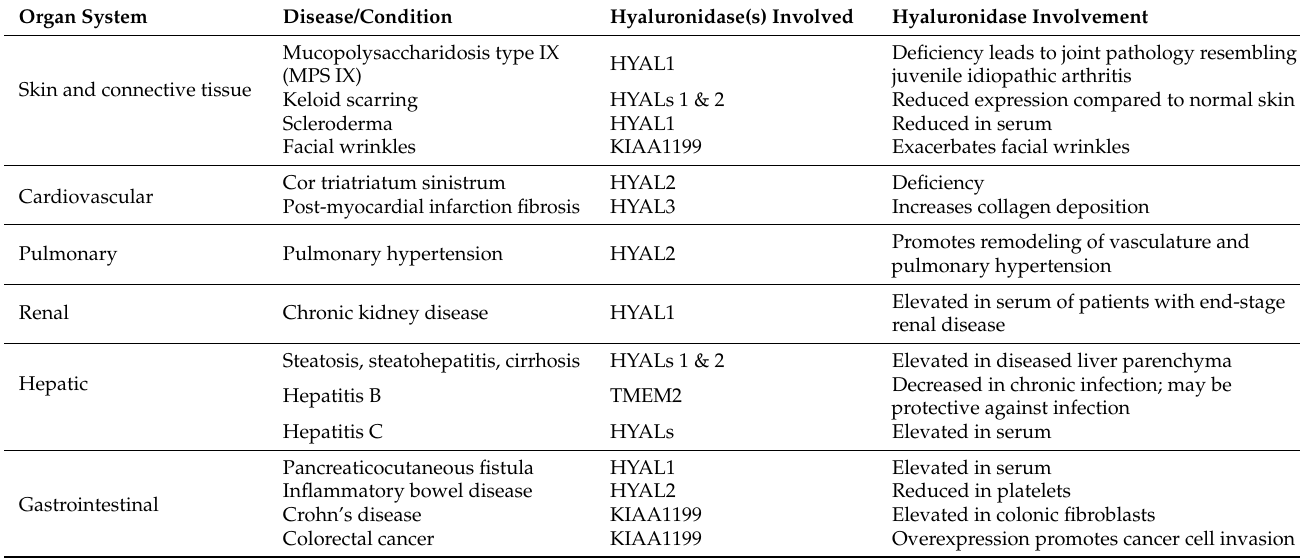
Table 2. Role of Hyaluronidases in various disease processes. This table details the known involvement of hyaluronidases in specific disease